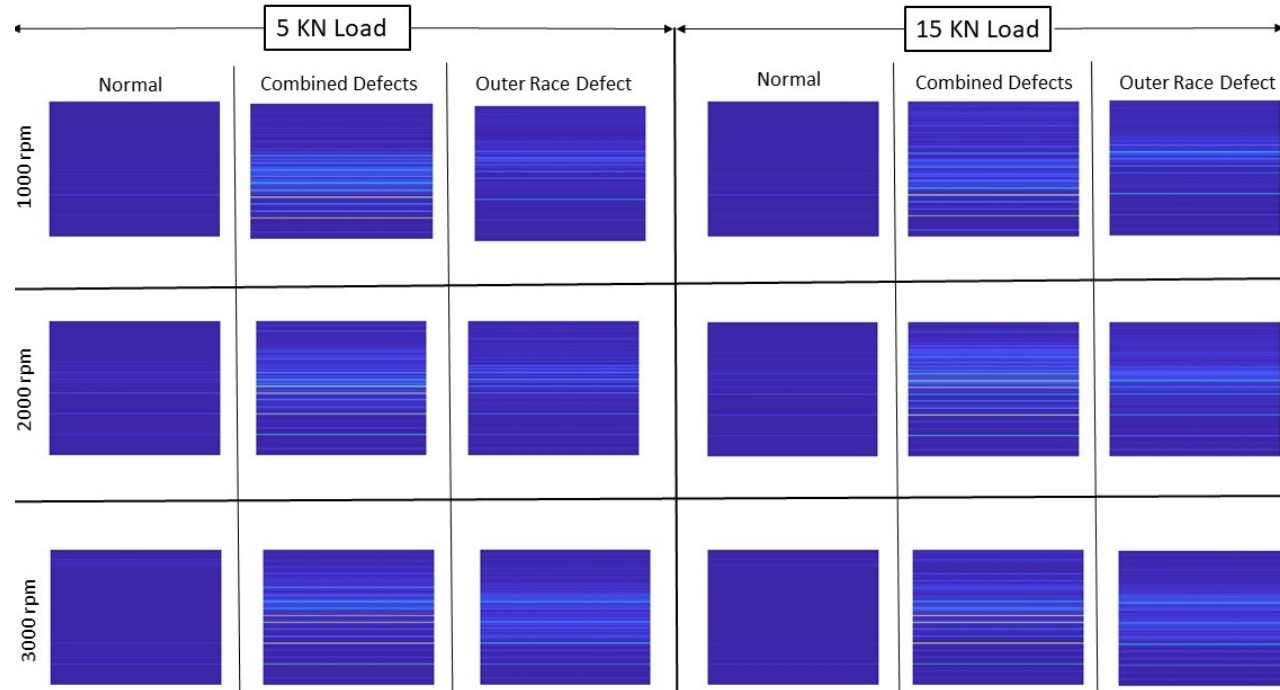
Figure 4. Order maps of bearings with different types of defects at different speeds and